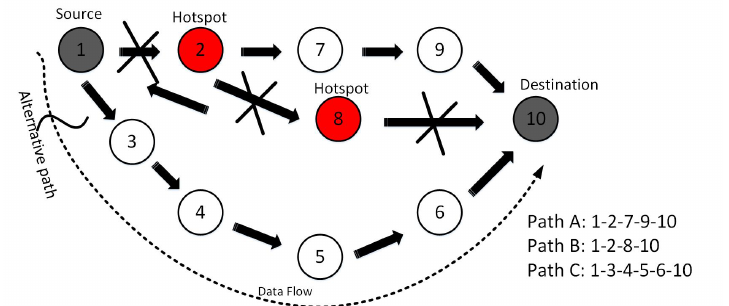
Figure 6. Alternative path C for traffic: The red node represents hotspot node that has a high temperature. Whenever the packet will be transferred form Path A and Path B it will backtrack the packet to previous node and communication will continue from the path C.